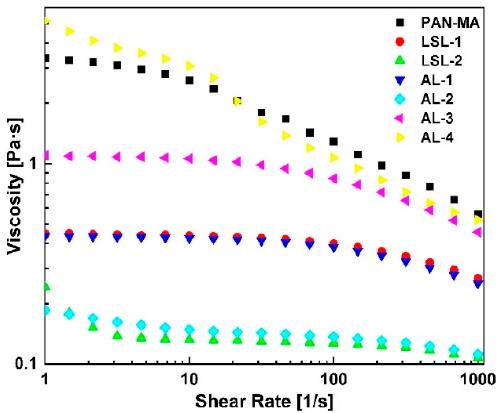
Figure 2. Steady-flow rheology results of all polymer solutions revealed that viscosity can be tuned based on the lignin content and the total polymer concentration. [PAN-MA in DMF (squares) was prepared at a 10 wt % in DMF and used as a control sample].